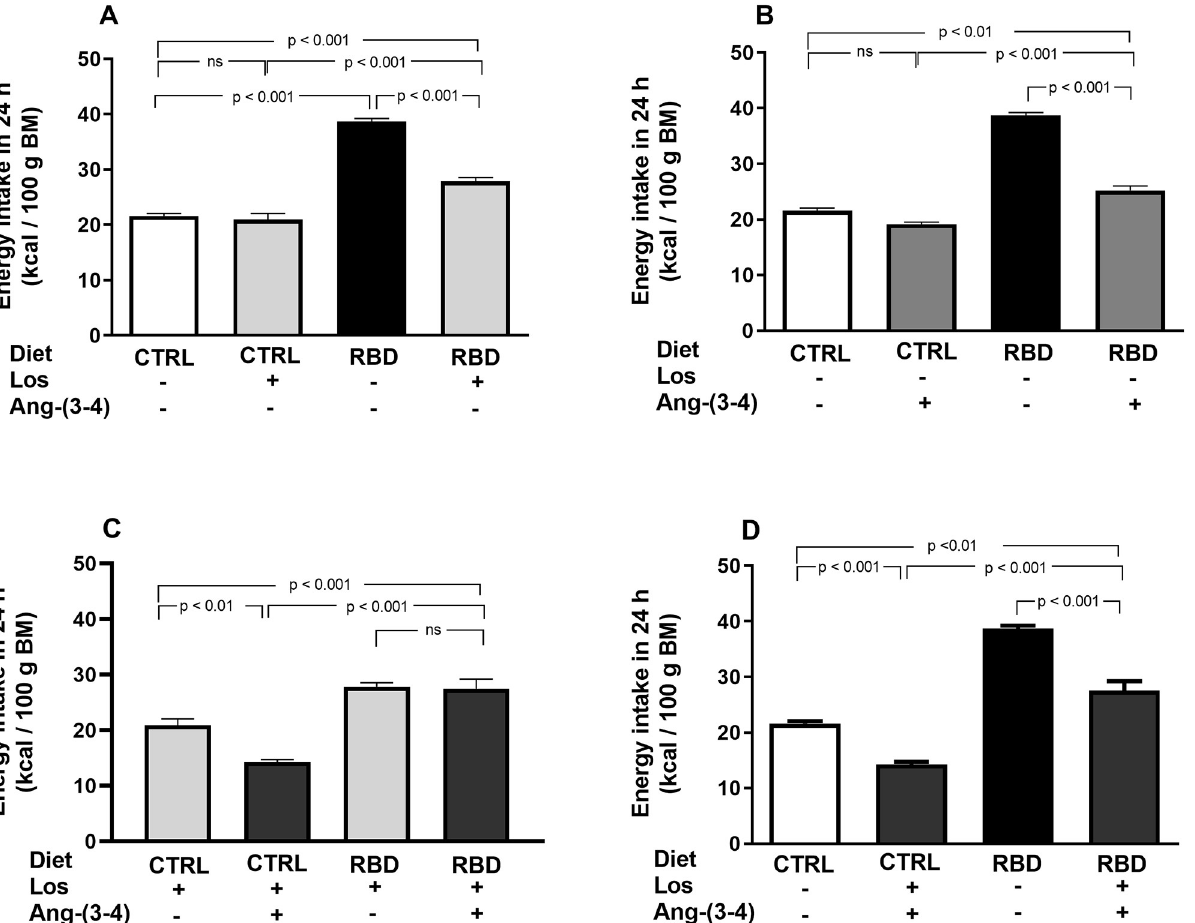
Fig 4. Energy intake. (A) Responses to Losartan. Comparison of energy intake by CTRL and RBD rats without chronic administration of Losartan, and effects of Losartan administration, as indicated on the abscissa . (B) Responses to Ang-(3–4). Effects of oral administration of a single dose of Ang-(3–4) on energy intake by CTRL and RBD rats, as indicated on the abscissa . (C) Responses to Ang-(3–4) in rats previously treated with Losartan. Effects of oral administration of a single dose of Ang-(3–4) on energy intake by CTRL and RBD rats previously treated with Losartan, as indicated on the abscissa . (D) . Responses of combined Losartan+Ang-(3–4) administration. Comparison of energy intake between untreated CTRL and RBD rats vs . CTRL and RBD that were chronically given Losartan and a single dose of Ang-(3–4), as indicated on the abscissa . Energy intake was calculated from food intake and the diet composition described in Table 1. Bars are mean ± SEM (data expressed per 100 g BM); n = 5 (CTRL), n = 8 (RBD), n = 5 (CTRL+Los), n = 6 (RBD+Los), n = 5 (CTRL+Ang-(3–4)), n = 8 (RBD+Ang-(3–4)), n = 5 (CTRL+Los+Ang-(3–4)), n = 6 (RBD+Los+Ang-(3–4)). Differences were assessed using one-way ANOVA followed by Bonferroni’s test for selected pairs. P values are indicated within the